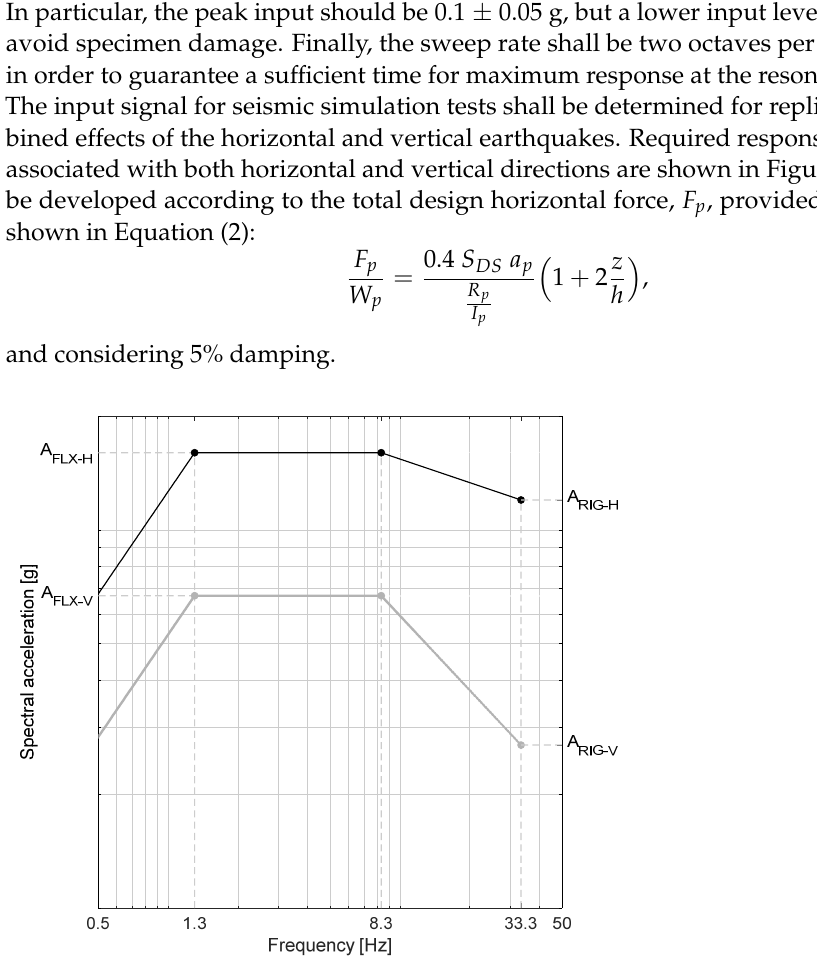
Figure 12. Required response spectra in the horizontal (black) and vertical (grey) directions according to AC156, 5% damped.